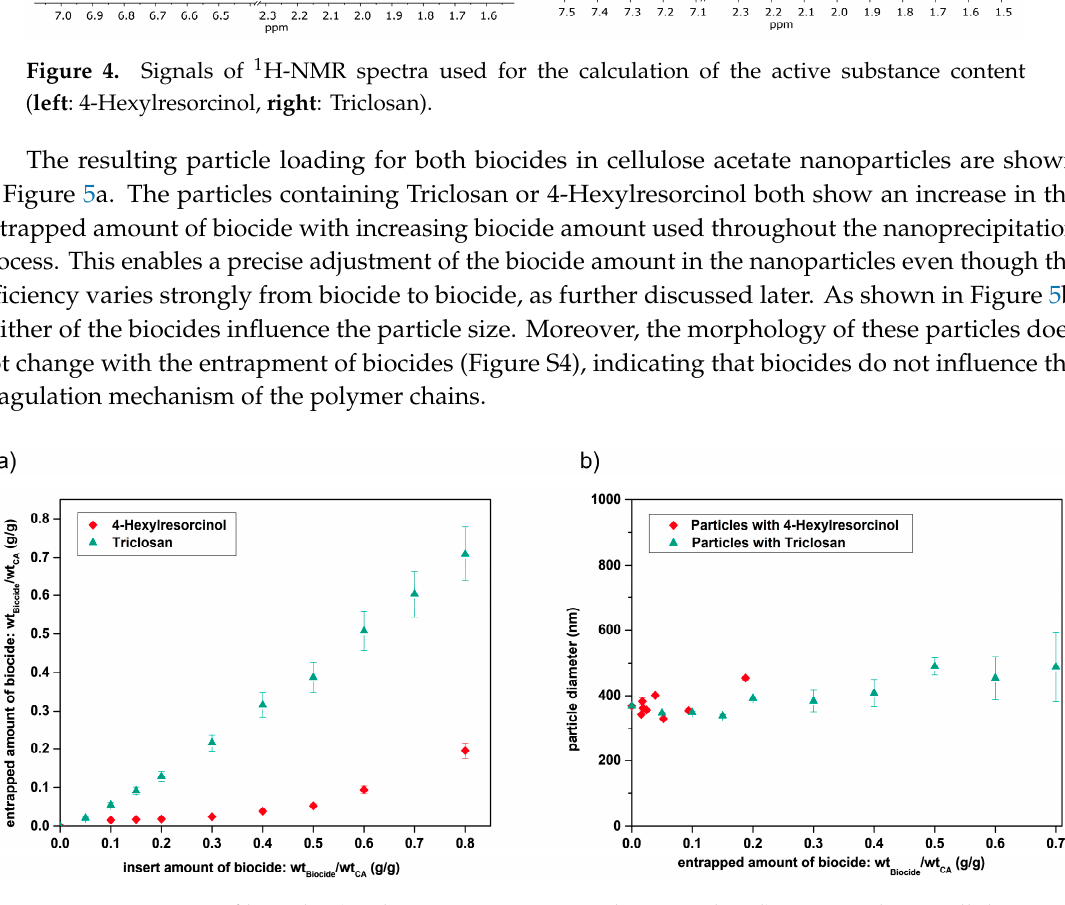
Figure 5. Amount of biocides (Triclosan, green or 4-Hexylresorcinol, red) entrapped into cellulose acetate nanoparticles ( a ) corresponding nanoparticle size determination of Triclosan (green) and 4-Hexylresorcinol (red) loaded cellulose acetate nanoparticles determined by DLS analysis ( b ).